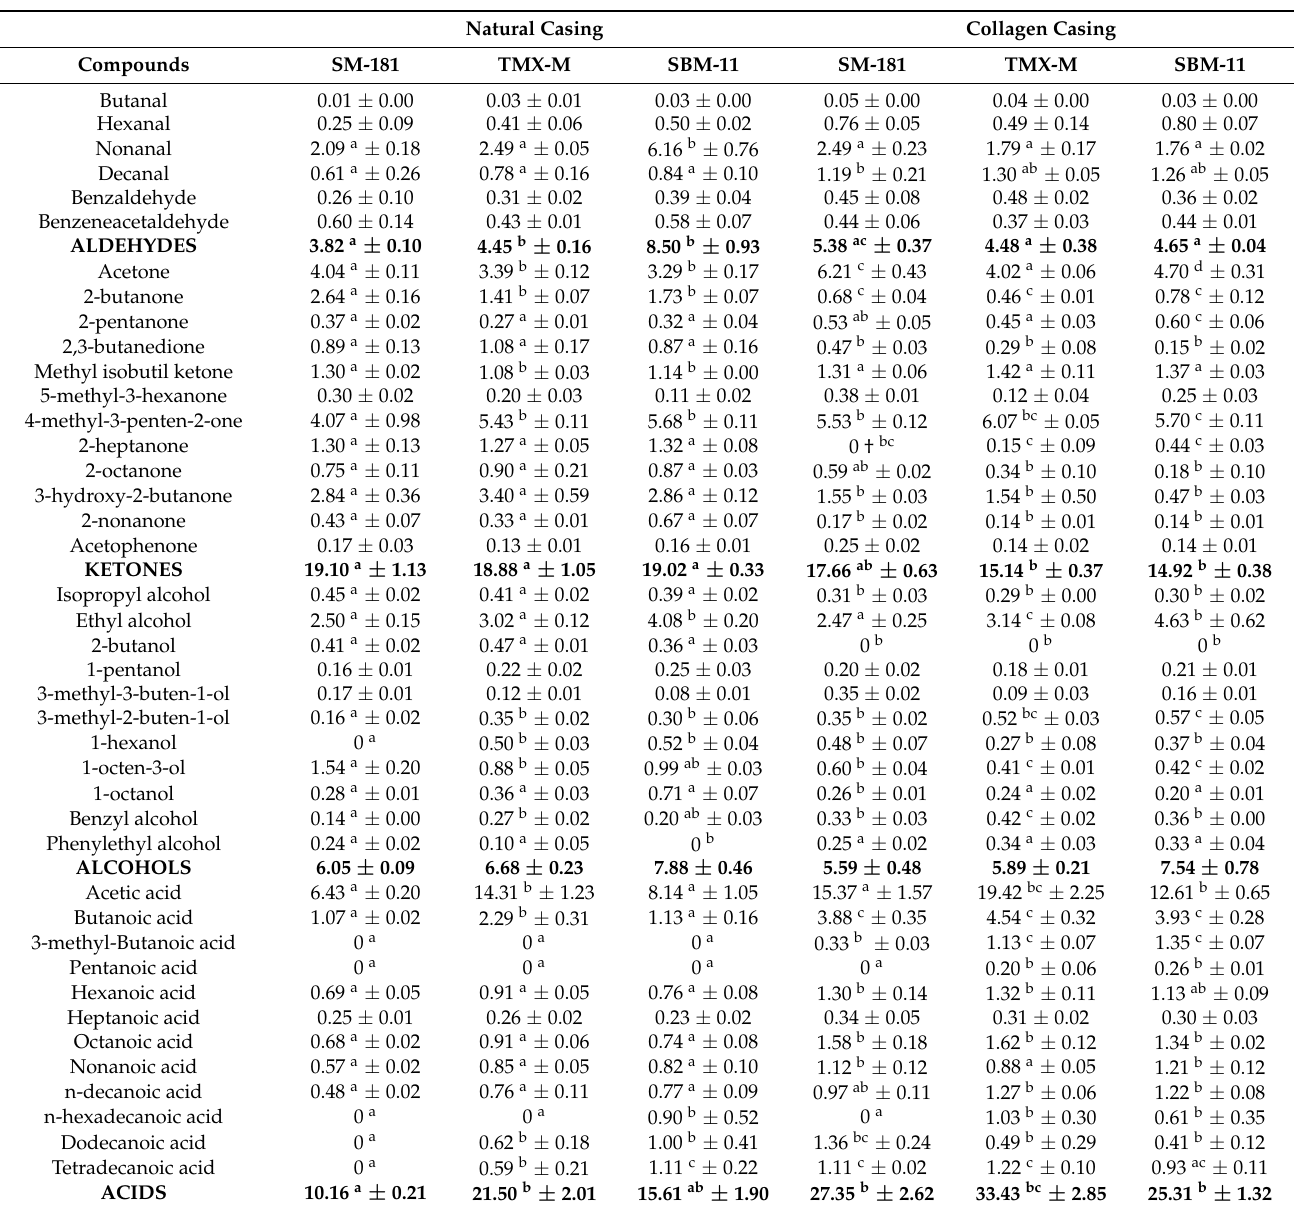
Table 2. Volatile organic compounds (VOCs) of ripened fermented sausages detected by SPME-GC- MS, expressed as a ratio between the peak area of each molecule and the peak area of the internal standard. The results of a two-way ANOVA are also reported to evaluate the effects of the different experimental conditions and their interactions on VOCs accumulation. Differences were considered significant at p ≤